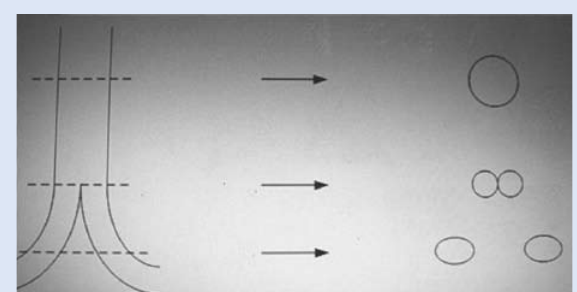
Fig 2. Illustration of axially imaged central airways. The cuts demonstrated are through the trachea, carina and main bronchi. An axial cut through the vertical trachea provides an accurate diameter of this tubular structure. If a more oblique structure is cut axially, the shape is oblong and may give an inaccurate measurement if there is asymmetrical compression.